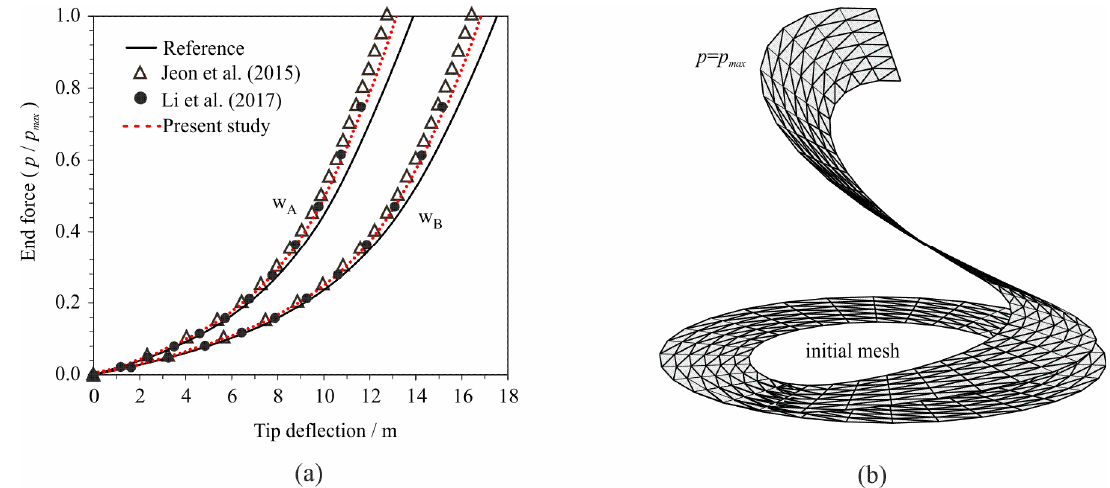
Figure 16. ( a ) Load-deflection curves for the slit annular plate lifted by line force p ; ( b ) the deformed mesh at p = p max .